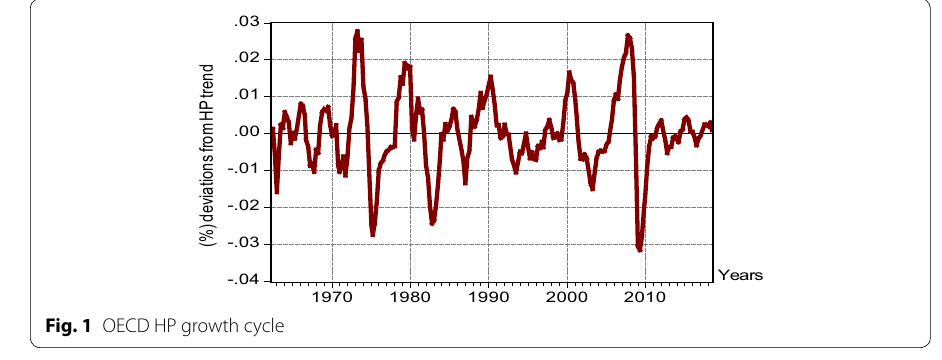
Fig. 1 OECD HP growth cycle